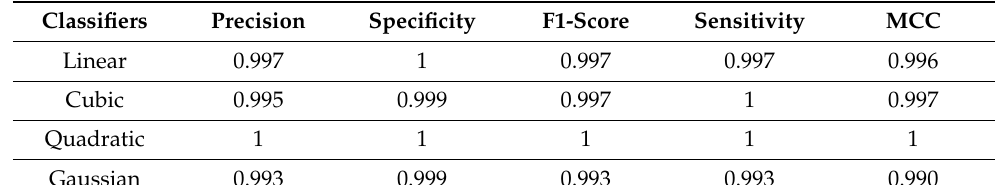
Table 3. The diagnostic accuracy (%) of the SVM classifiers trained with independent DL Feature sets and concatenated with the combined handcrafted features set from multiple domains. Table 4. Evaluation indices values calculated from the SVMs in configuration III.